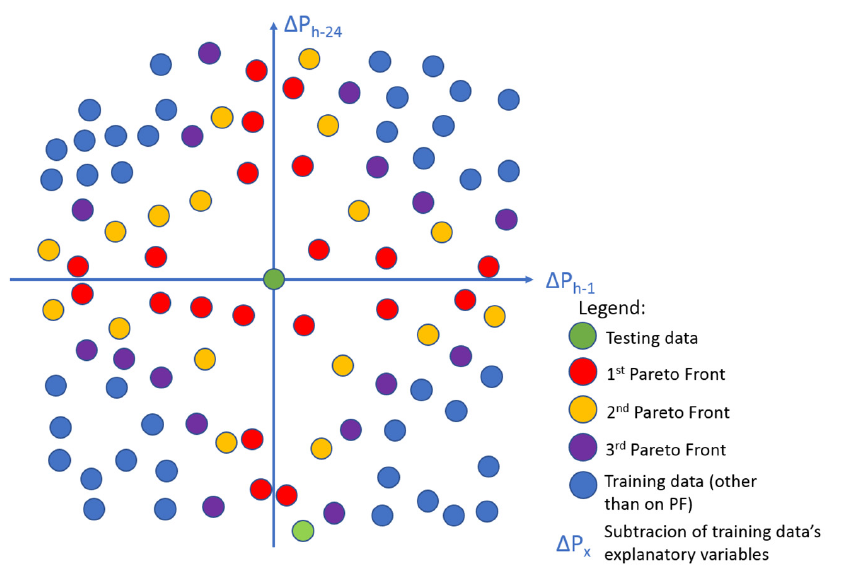
Figure 6. The example of testing data belonging to the first, the second, and the third Pareto front in all four quadrants.